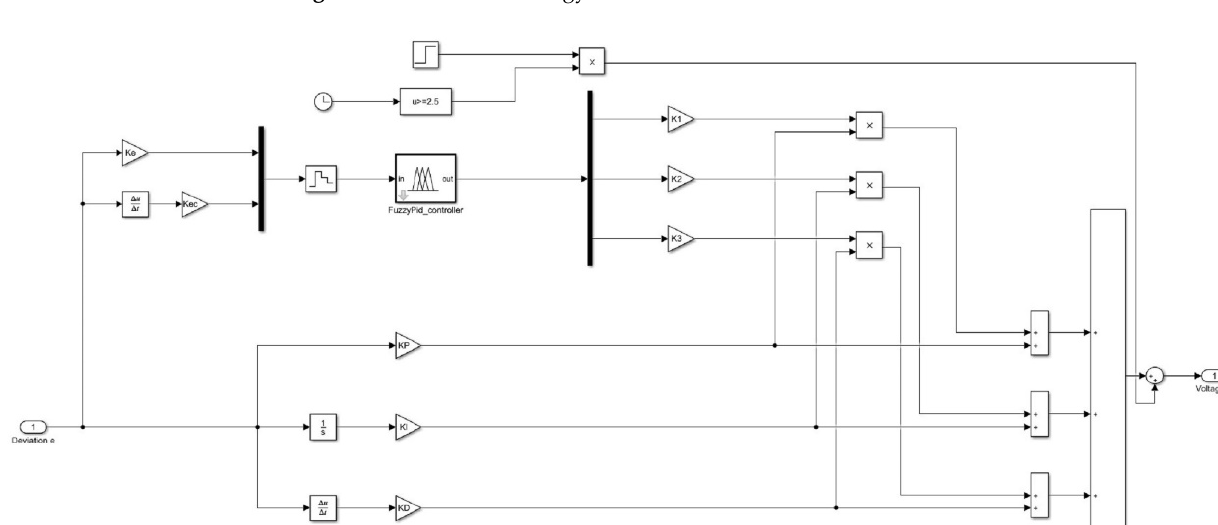
Figure 10. Adaptive fuzzy PID control strategy Simulink model.